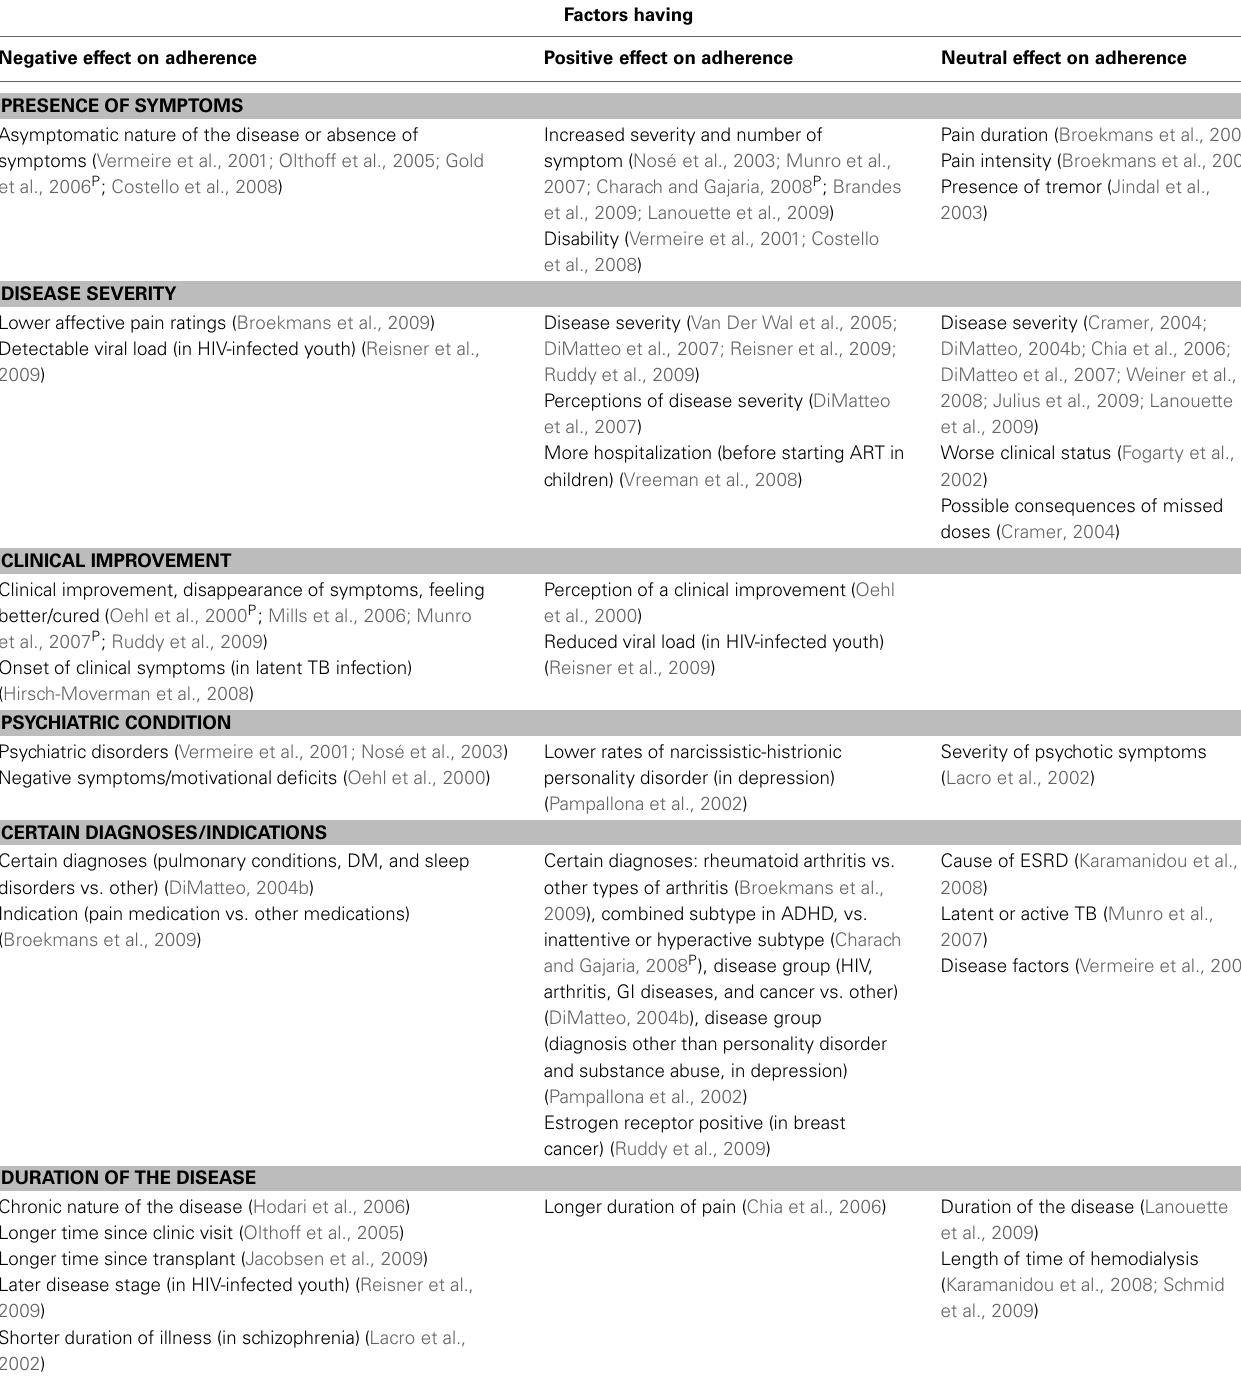
Table 5 | Condition-related factors affecting